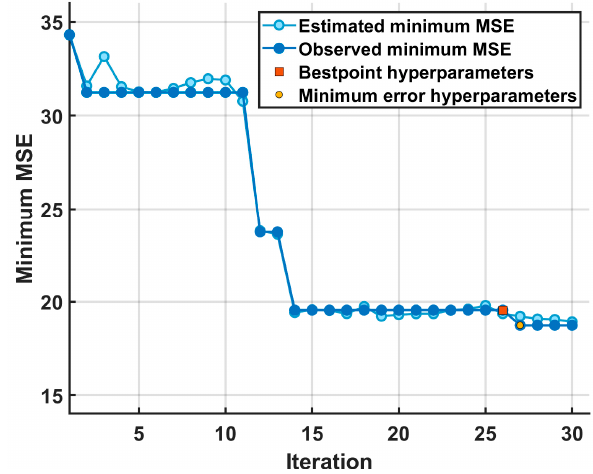
Figure 7. MSE optimization plot of the EL model.